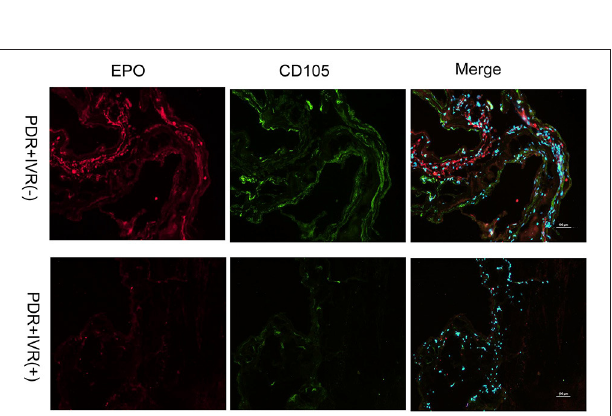
FIGURE 5 | Epiretinal fibrovascular membranes (FVMs) showed negative for Vimentin and positive for the marker CD105 of neovascular endothelial cells in the Non-IVR group. Scale bars: 100 µ